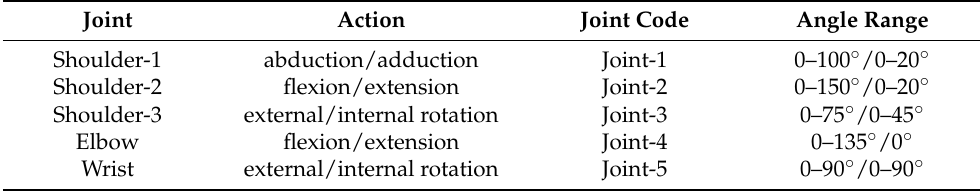
Table 2. Exoskeleton joint range of